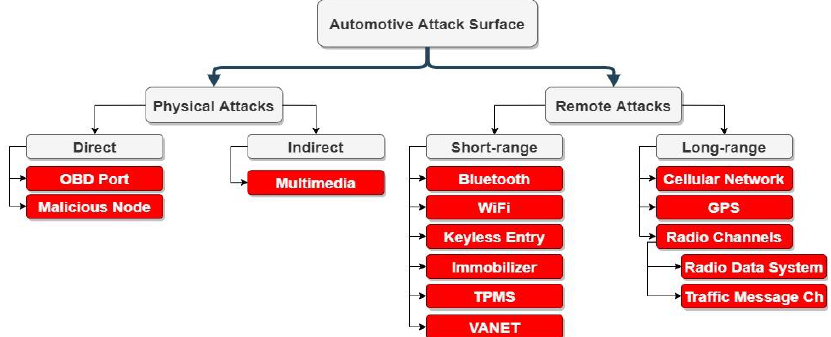
Figure 5. The automotive attack surface.